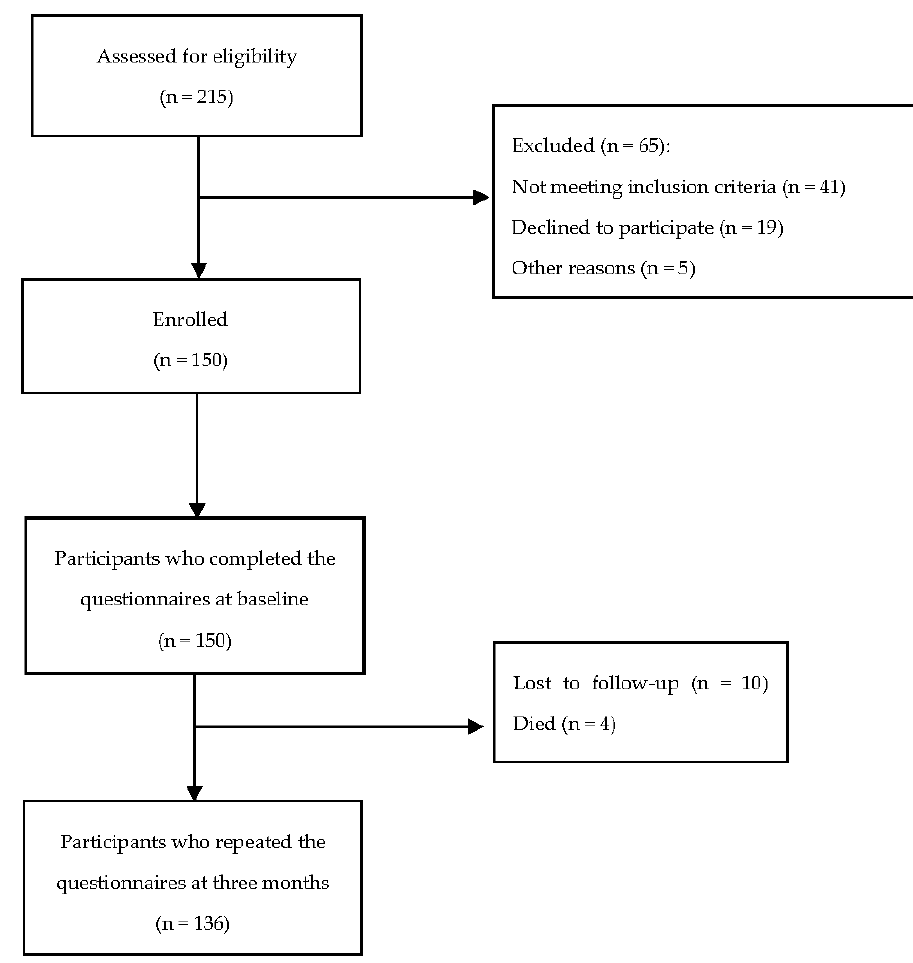
Figure 1. Flow diagram of participant recruitment.